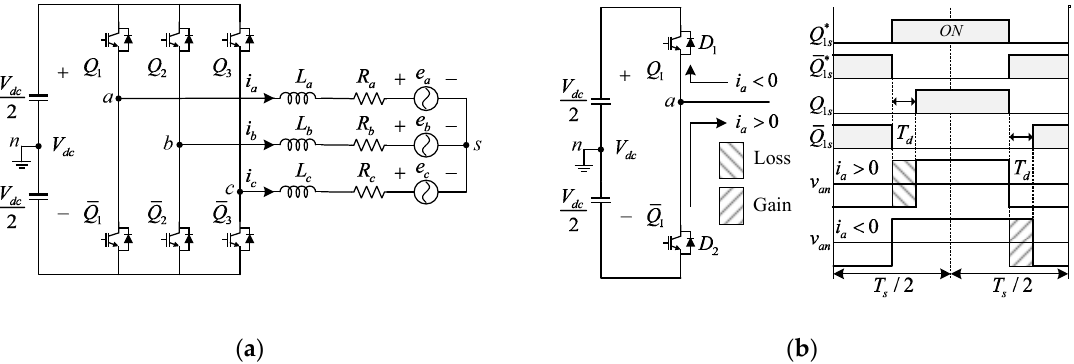
Figure 1. Three-phase VSI and dead-time switching patterns of a-phase leg: ( a ) Typical three-phase VSI configuration; ( b ) switching patterns and current flow direction of the one phase leg during the dead-time.